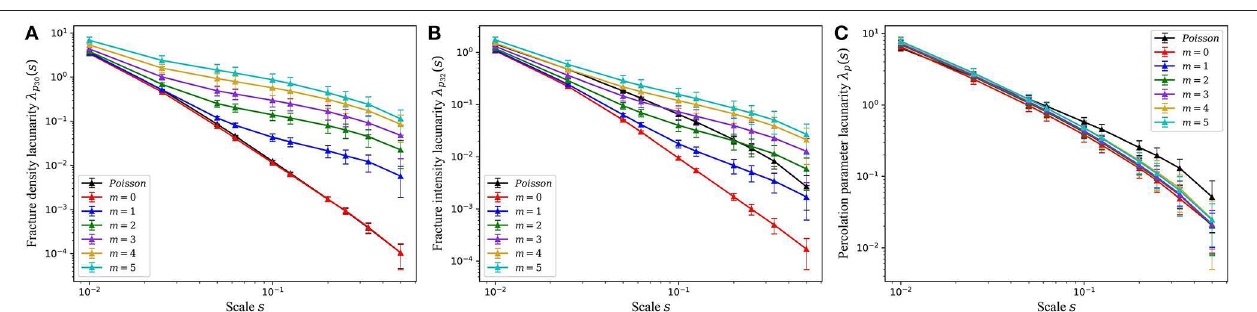
FIGURE 5 | Fracture density lacunarity curves for (A) p 30 , (B) p 32 , and (C) percolation parameters.